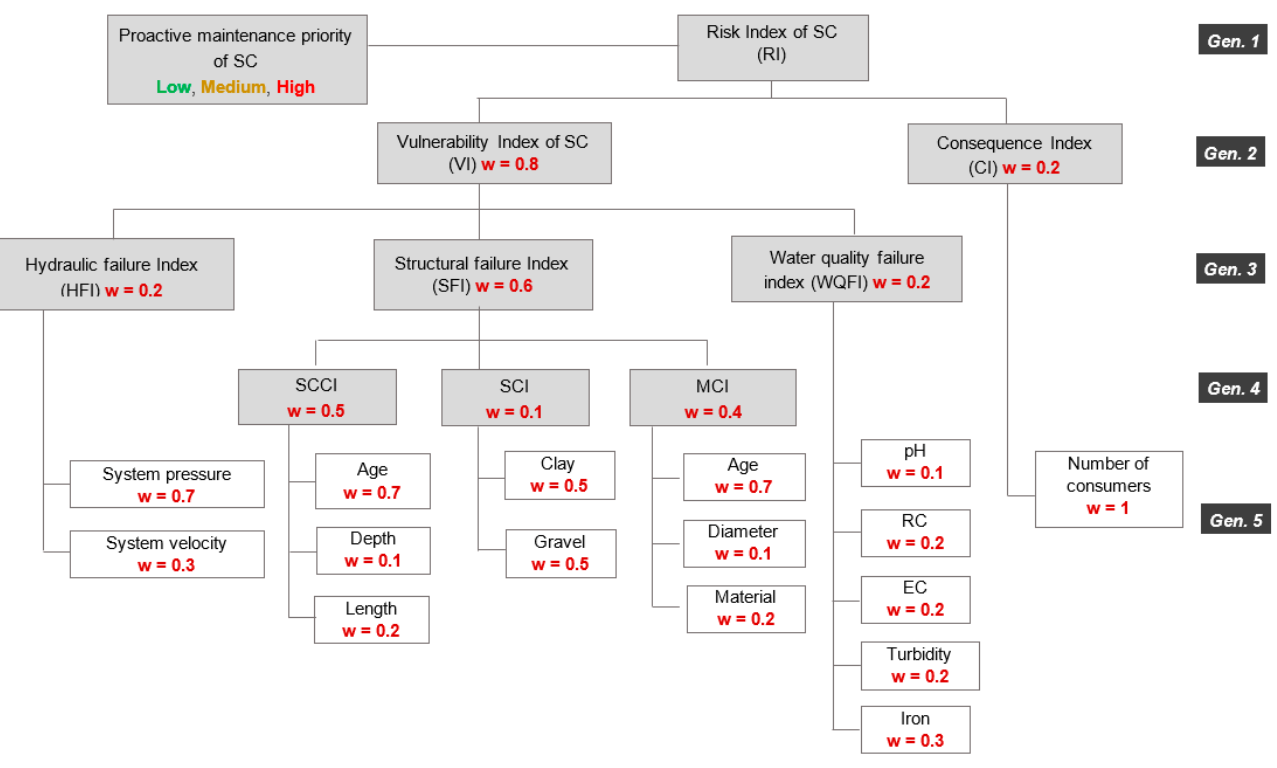
Figure 7. Weighting scheme by Fuzzy-AHP showing input data variables at Gen. 5, risk factors at Gen. 2 to Gen. 4, and risk index (RI) at the top.